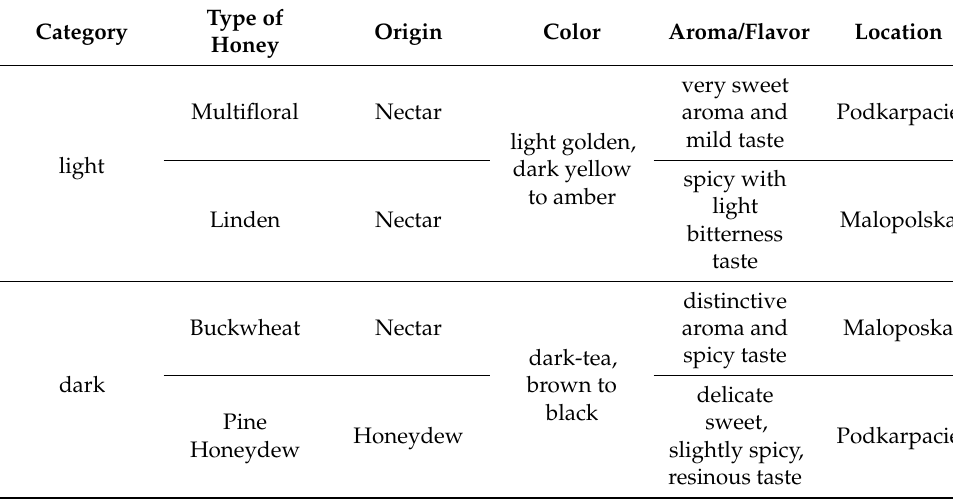
Table 6. The characteristics of honey